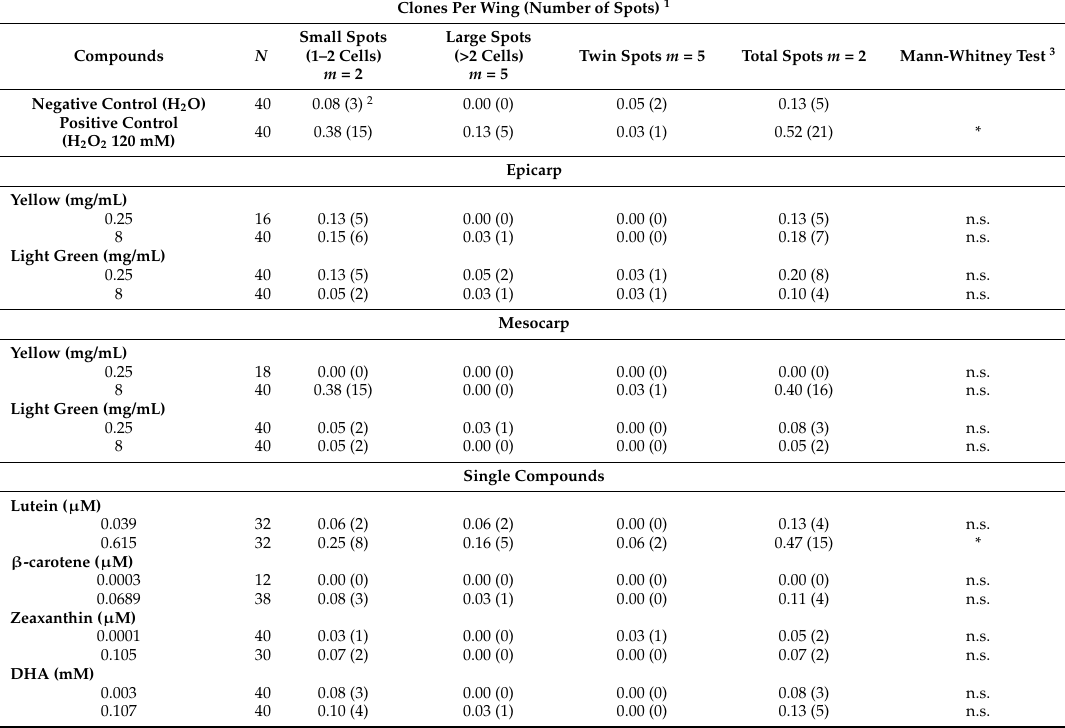
Table 3. Anti-genotoxicity (combined treatment) of epicarp and mesocarp of two varieties of C. pepo and its active compounds (lutein, β -carotene, zeaxanthin and dehydroascorbic acid) in the Drosophila Wing Spot